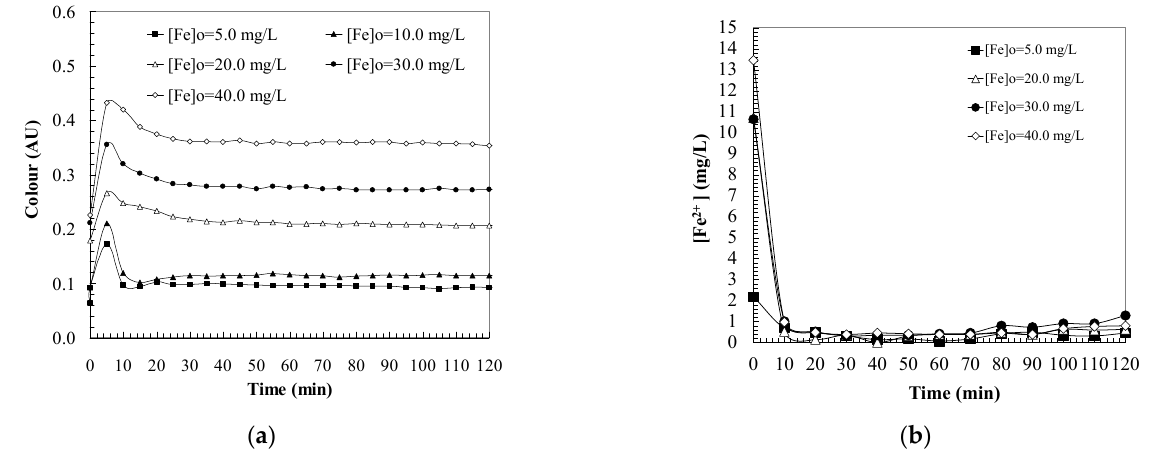
Figure 7. ( a ) Effect of iron on colour changes in a photo-Fenton system during the carbamazepine oxidation. ( b ) Ferrous ions concentration in water solution during carbamazepine oxidation. Experimental conditions: [CBZ] 0 = 50.0 mg/L; pH = 3.0; [H 2 O 2 ] 0 = 15.0 mM; [UV] = 150 W; T = 40 ◦ C.